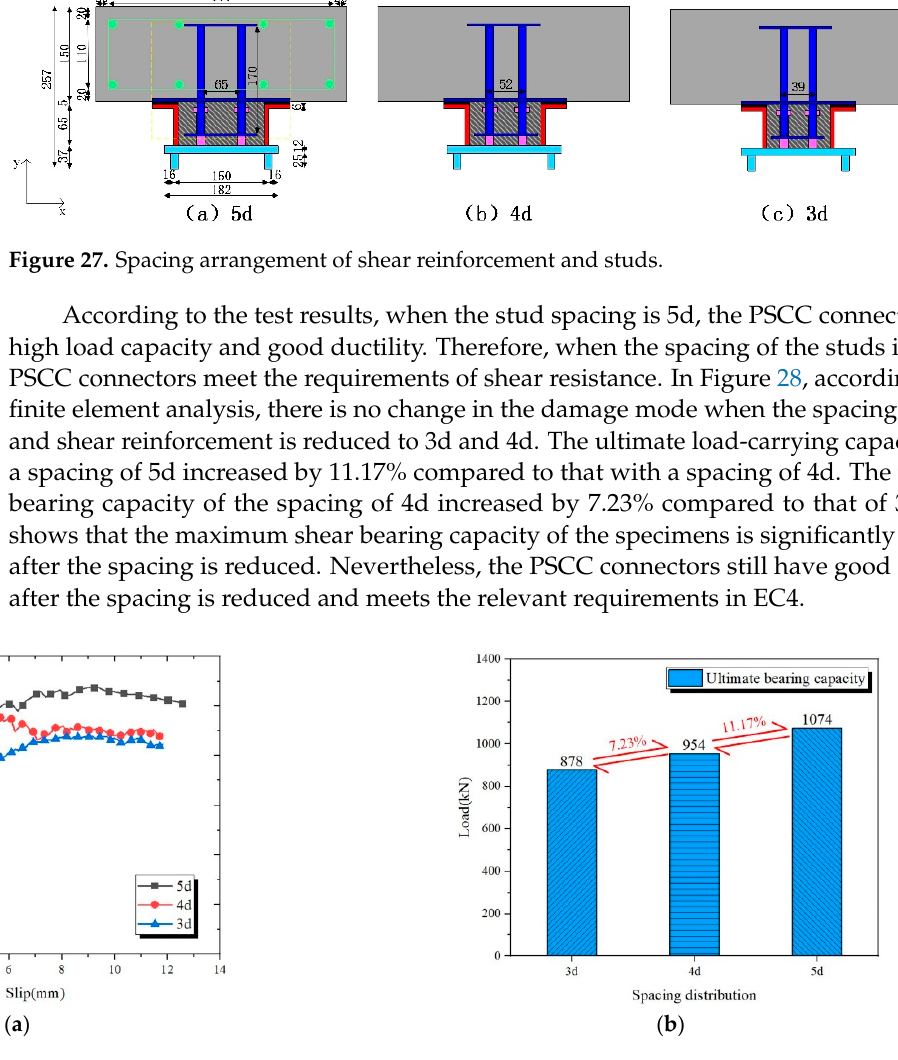
Figure 28. Analysis results of spacing arrangement: ( a ) Load-slip curves; ( b ) Comparison of ultimate shear capacity.